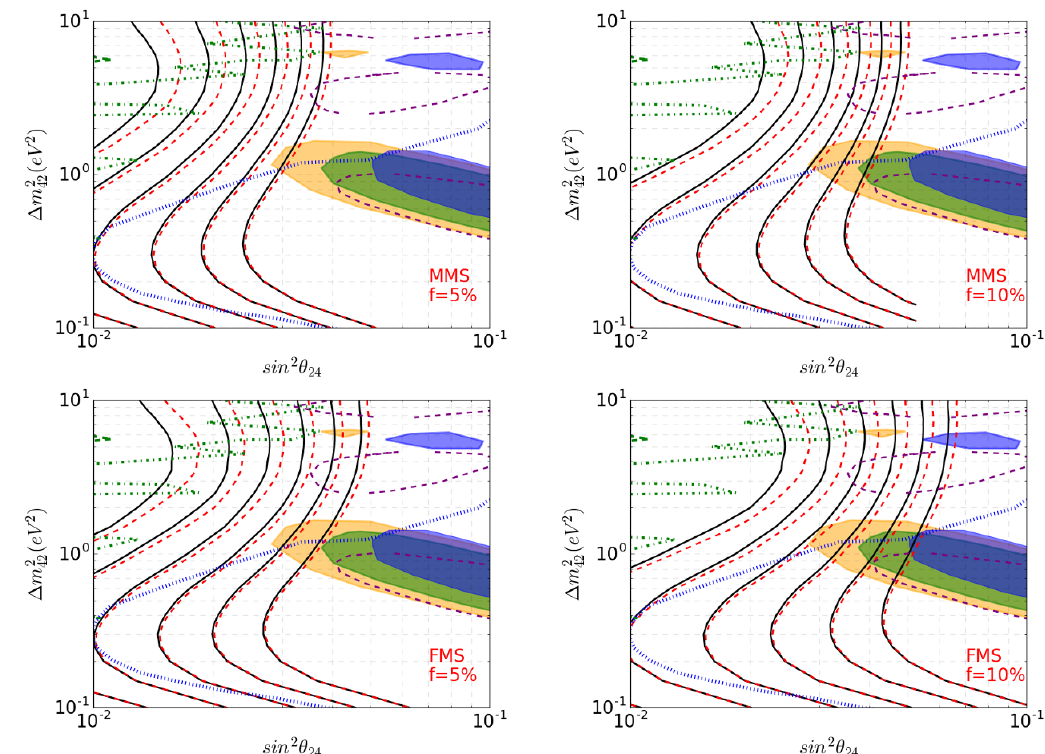
Figure 5 . Exclusion regions in the sterile neutrino mixing parameter space for the mass-mixing (MMS at top panels) and (cid:13)avor-mixing (FMS at bottom panels) schemes. The left (right) panels are for f = 5% (10%) uncorrelated systematic uncertainties. The continuous black lines correspond to con(cid:12)dence levels from 1 (cid:27) to 6 (cid:27) with initial conventional atmospheric (cid:13)ux and the red dashed lines correspond to the same but including also the atmospheric prompt (cid:13)ux contribution. The blue dotted line corresponds to IceCube’s 99% CL exclusion region [37] and the green dot-dashed line represents 99% CL exclusion region from the combined disappearance experiments [62]. The shaded areas correspond to allowed regions from the appearance experiments. The latest MiniBooNE 3 (cid:27) allowed regions are shown with purple dashed contours [44]. See main text for more details. Also, in (cid:12)gure 5 we show IceCube 99% CL exclusion region [37] with the blue dotted line and a 99% CL exclusion region using combined disappearance experiments, including IceCube, with the green dot-dashed line [62]. The orange shaded areas represent allowed regions with 99 : 73% CL (3 (cid:27) ) for combined appearance experiments including decay-in- (cid:13)ight (DiF) data. The blue shaded areas are allowed regions at 99% CL and excluding the DiF data, while the green shaded area is the same allowed region at 99% CL but including the DiF data. The purple dashed contours for the MiniBooNE latest result correspond to 3 (cid:27) allowed region [44]. When it is necessary to convert mixing angles from appearance or disappearance experiments we use the